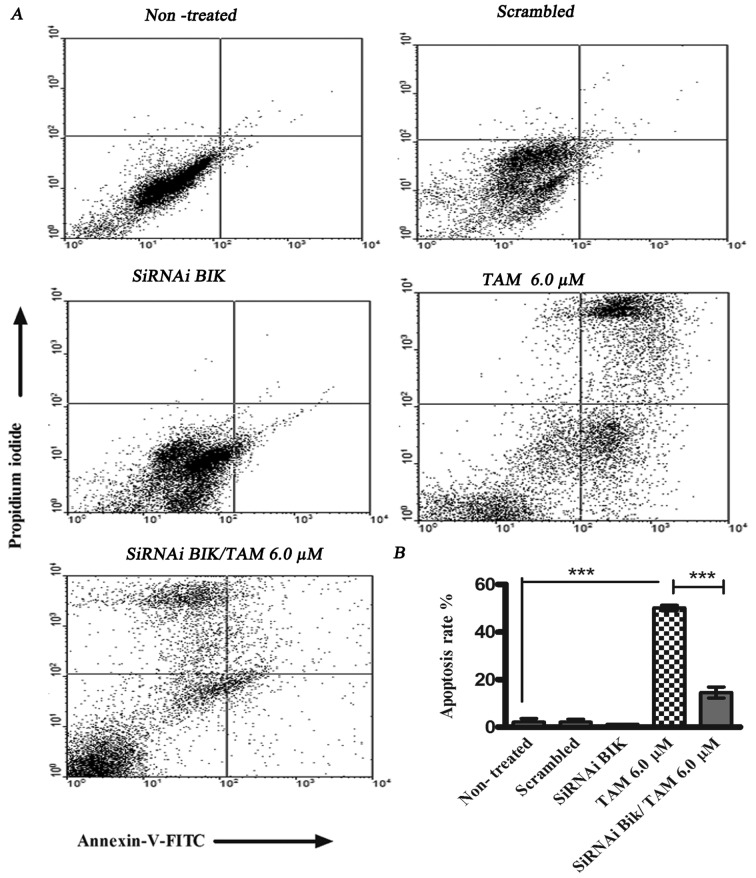
Suppression of the Bik gene promotes inhibition of caspase activity. (A) MCF-7 [non-treated, scrambled, siRNAiBIK, siRNAiBIK/tamoxifen (TAM), and TAM] were then labeled with the FAM-VAD-FMK probe and PI for determination of caspase activation. The samples were analyzed on a flow cytometer with 488 nm excitation using 530 nm band pass and 670 nm long pass emission filters. (B) Representative graphic of fluorescence intensities. Results are representative of three independent experiments. The groups were analyzed by one-way ANOVA with the Tukey’s test. *p<0.05; **p<0.01; ***p<0.001 vs. non-treated. Representative figures of three independent experiments carried out in triplicate are shown.